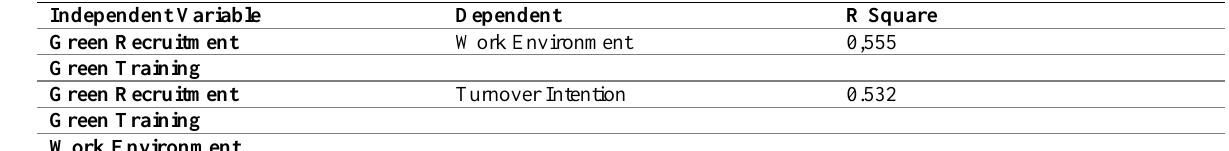
Table 5: R-Square Test Results